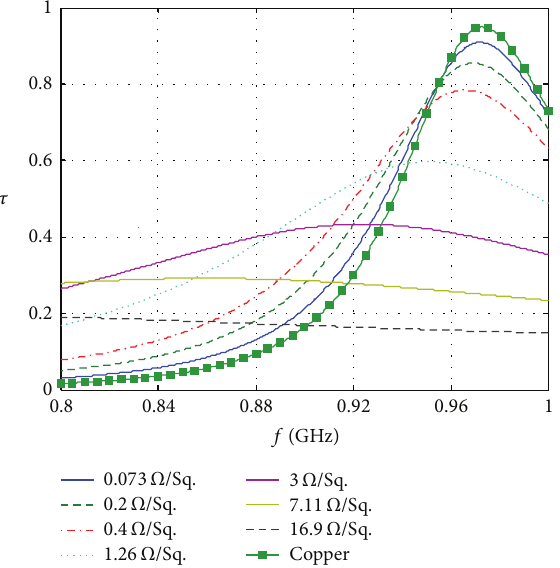
Figure 2: Simulated antenna-IC power transfer efficiency. 𝐷 is the tag antenna directivity, and 𝜏 is the antenna-IC power transfer efficiency determined by the antenna and and 𝑍 , respectively. Equation (1) is a IC impedances 𝑍 ant ic direct implication of Friis’ simple transmission equation.